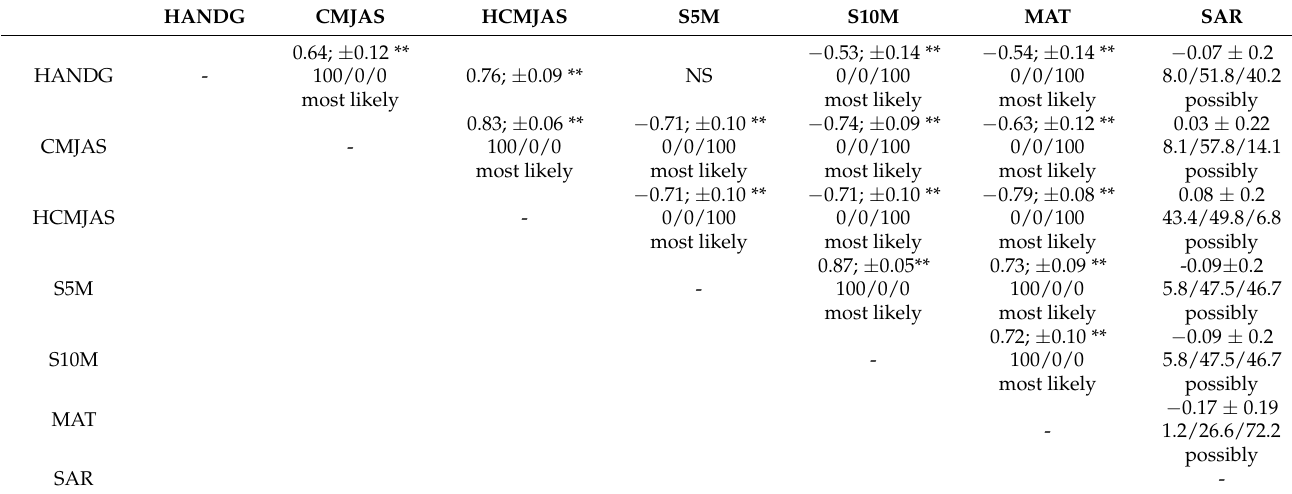
Table 4. Correlation analysis (r; ± 90% CL) among handgrip isometric strength, vertical jump, horizontal jump, sprint, change of direction ability, and flexibility tests for all the table tennis players